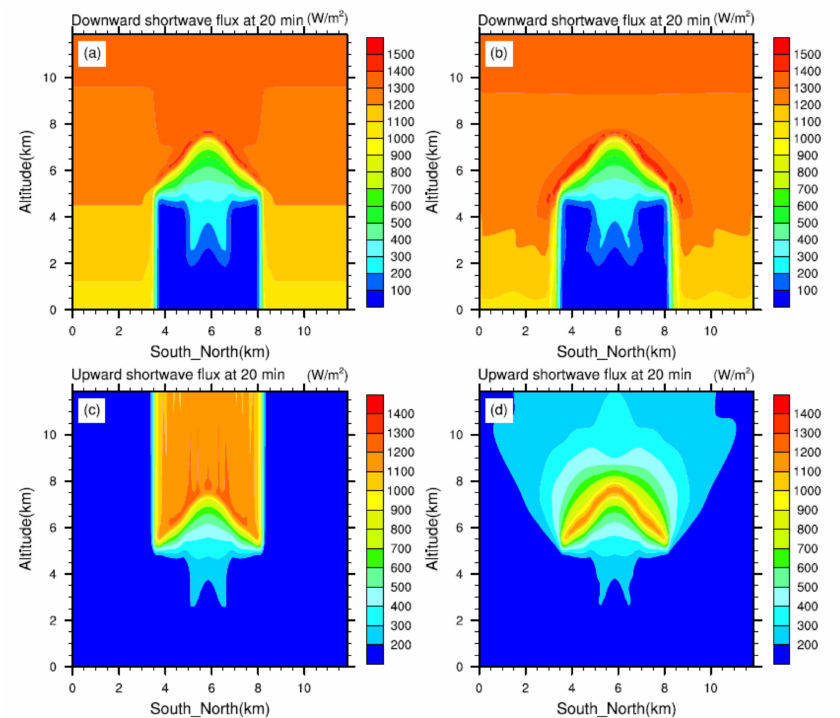
Figure 3. Downward and Upward shortwave radiation flux in the 1D radiation case ( a , c ) and the 3D radiation case ( b , d